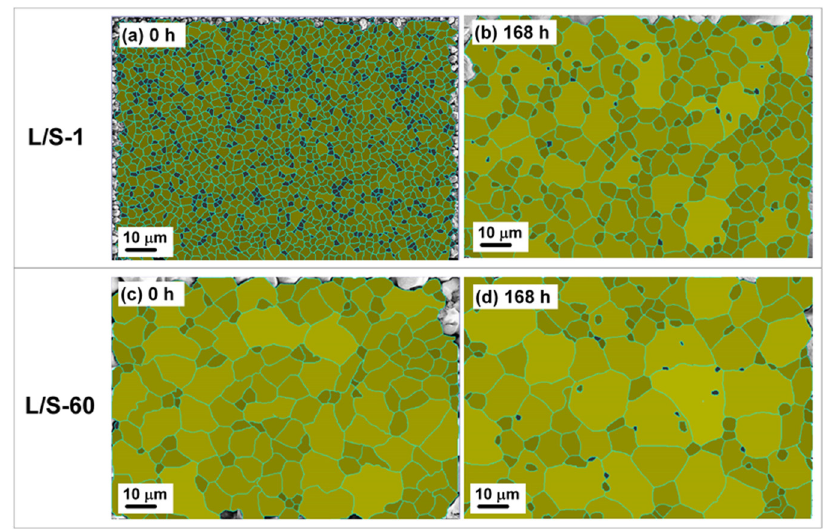
Figure 9. Size measurement of the Cu 6 Sn 5 grains in the L/S-1 ( a,b ) and L/S-60 ( c,d ) samples subjected to S/S reaction for various lengths of time.